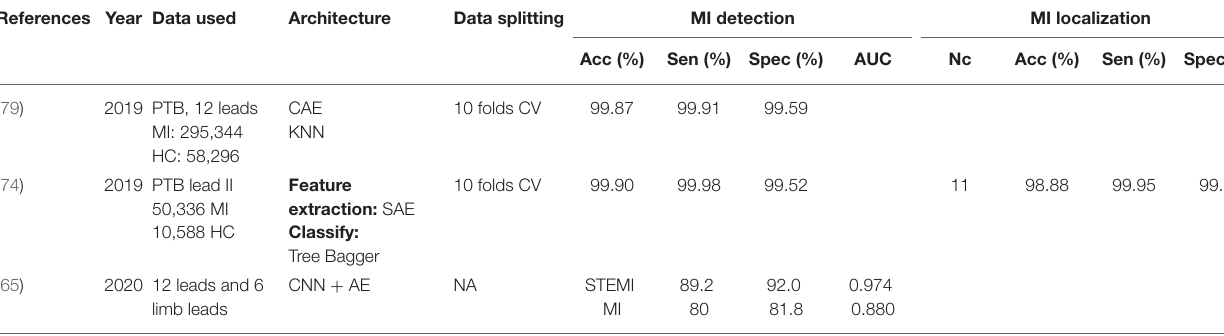
TABLE 7 | Properties of some notable autoencoder (AE)-based ECG MI detection and localization. References Year Data used